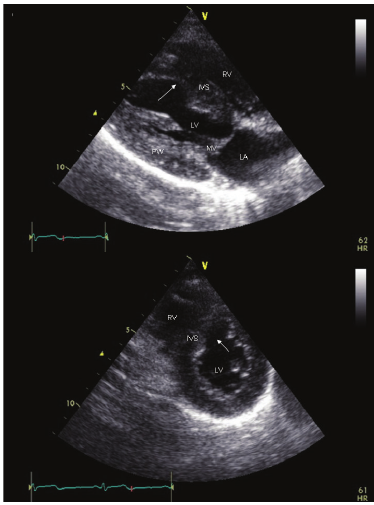
Figure 2: Echocardiographic images taken during ventricular systole from the parasternal long-axis view (top panel) and short- axis view (bottom panel), showing akinesia of the middle segment of the ventricular septum (arrows). Note the lack of systolic thickening of the akinetic segment, as compared to the others. IVS: interven- tricular septum; LA: left atrium; LV: left ventricle; MV: mitral valve; PW: posterior wall of the left ventricle; RA: right atrium; RV: right